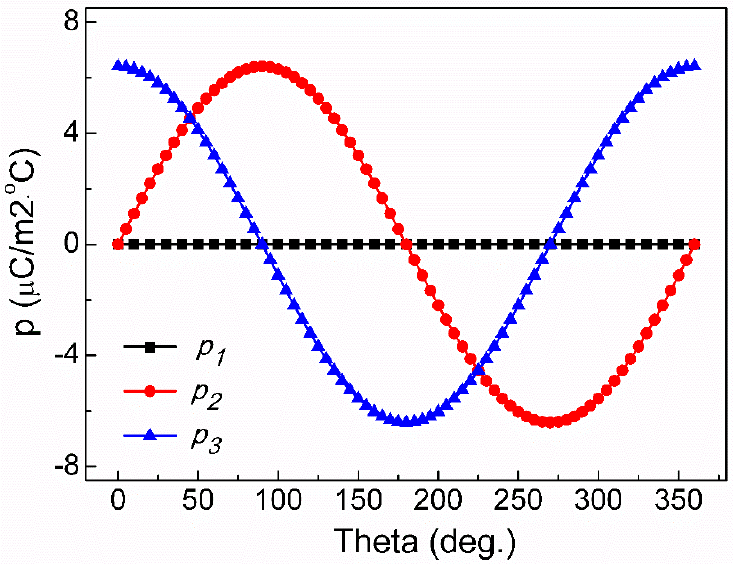
Figure 4. Orientation dependence of p i for BZBO crystals .